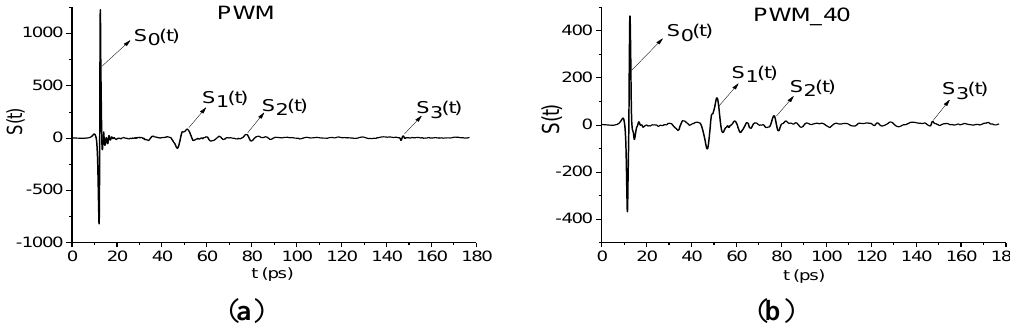
Figure 13. Reflected THz PWM signal ( a ) and PWM_40 signal ( b ) in the long time interval 0 < t < 180